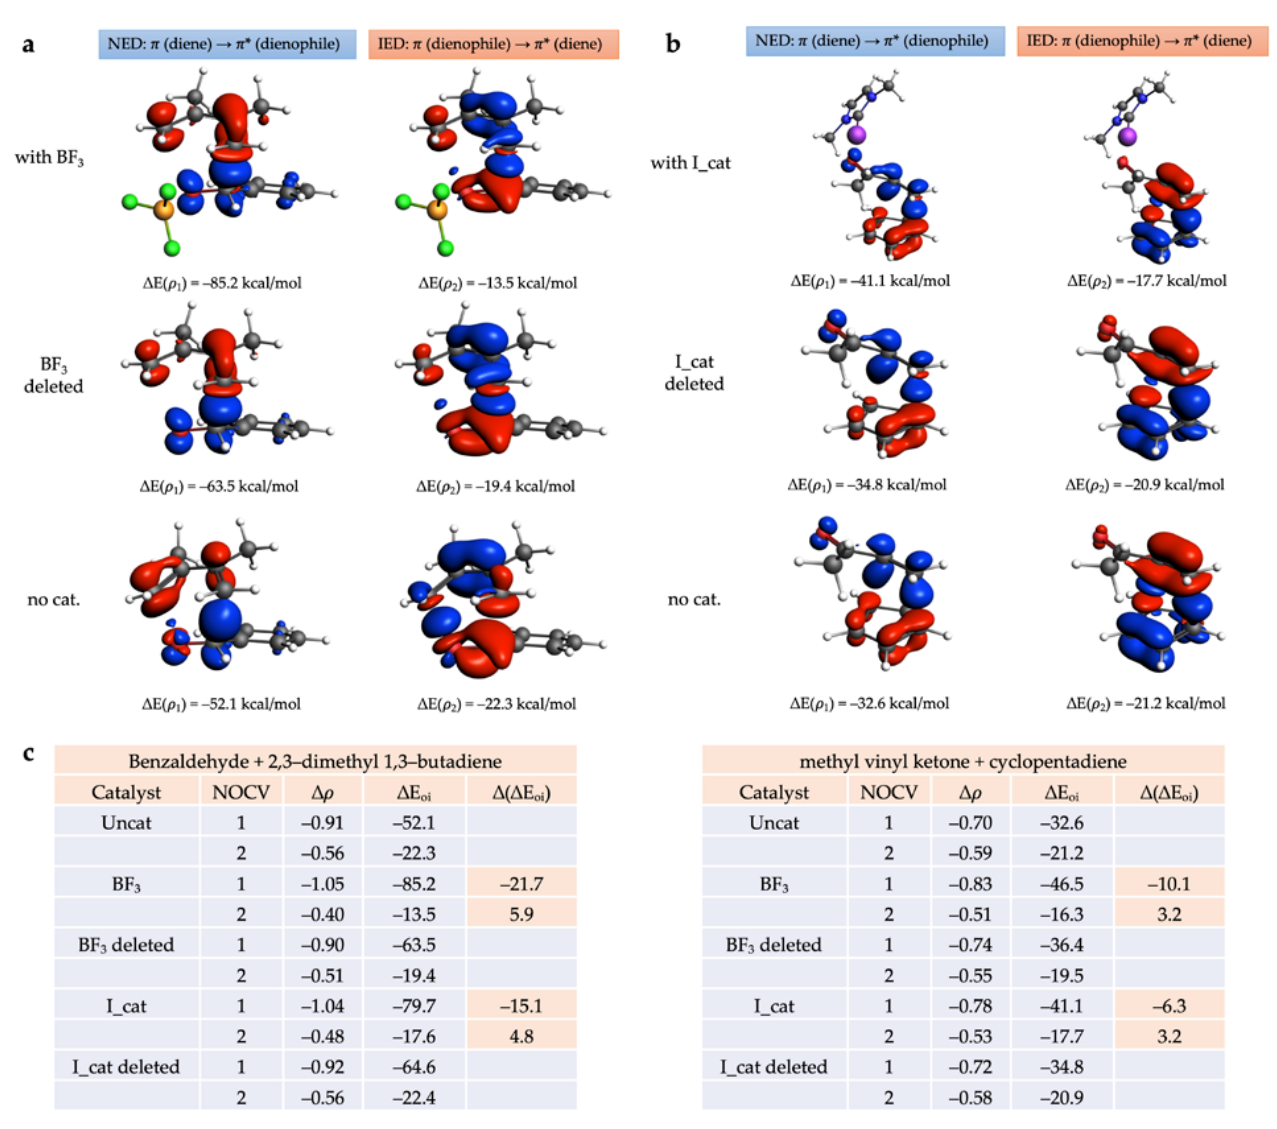
Figure 8. Contour plots of NOCV deformation densities (red for depletion, blue for accumulation) and associated orbital energies ∆ E( ρ ) for the normal-electron-demand (NED) and inverse-electron- demand (IED) interactions of ( a ) the BF 3 -catalyzed and uncatalyzed benzaldehyde + 2,3-dimethyl 1,3-butadiene Diels–Alder reaction, and of ( b ) the I_cat-catalyzed and uncatalyzed methyl vinyl ketone + cyclopentadiene Diels–Alder reaction. ( c ) NOCV deformation densities ∆ ρ and associated orbital energies ∆ E oi , with the difference between catalyzed and catalyst-deleted values for NED and IED interactions highlighted in orange.